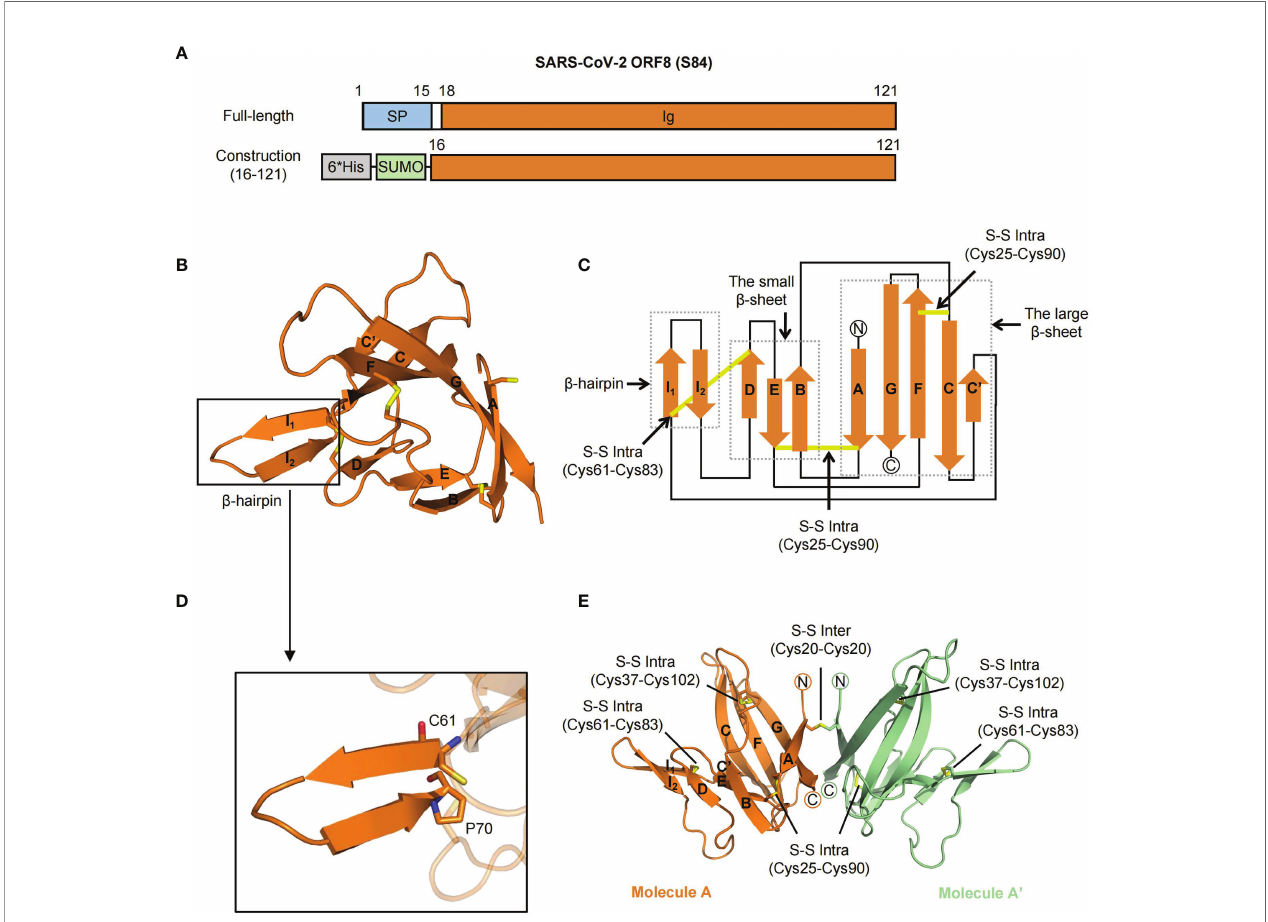
FIGURE 1 | The crystal structure of SARS-CoV-2 ORF8 (S84). (A) Overall domain architecture of SARS-CoV-2 ORF8 (S84), including full-length and N-terminal His- SUMO tag construction for protein expression. The numbers denote residue sites of the ORF8 protein. SP, Signal peptide; Ig, immunoglobulin domain; 6*His, 6- histidine; SUMO, small ubiquitin-related modi fi er. (B) Cartoon representation of SARS-CoV-2 ORF8 (S84) Ig-like domain in one asymmetric unit. Disul fi de bonds are showed with the stick model. The b -strands are assigned with the alphabet from N-terminus to C-terminus. The b -hairpin (in black box) consisting of strands b I 1 and b I 2 is inserted between b C ’ and b D. (C) Topological style illustration of structure SARS-CoV-2 ORF8 (S84) Ig-like domain. The dashed boxes represent b -hairpin, the small b -sheet ( b B, b D, and b E) and the large b -sheet ( b A, b C, b C ’ , b F, b G). Disul fi de bonds are showed with yellow lines. (D) Details of the b -hairpin of SARS-CoV-2 ORF8 (S84), which contain residues from Cys61 to Pro70. Residue Cys61 and Pro70 are shown with the stick model. (E) Cartoon representation of the homodimer of SARS-CoV-2 ORF8 (S84) in two symmetric units, which formed by Cys20 - Cys20 intermolecular disul fi de bond. Molecule A is colored with orange, and Molecule A ’ with green. Disul fi de bonds are presented in yellow with the stick model, including both intermolecular and intramolecular